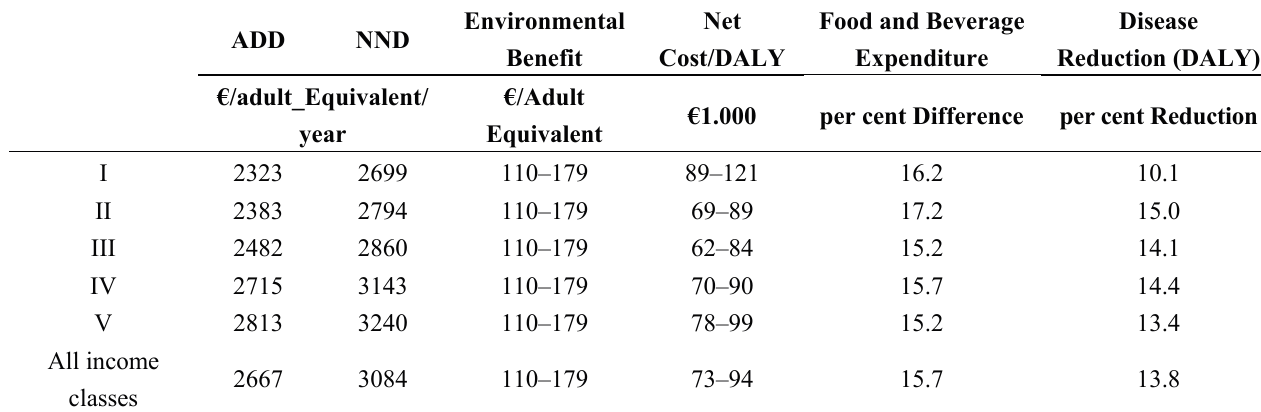
Table 2. Distributional effects,